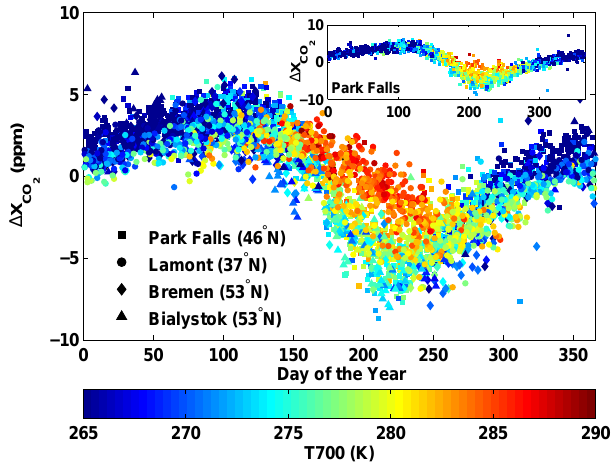
Fig. 6. Detrended X CO seasonal cycles measured at the four TC- 2 CON stations. The colors are the free-troposphere temperatures (at 700hPa, denoted T700). The color bar is scaled to emphasize the spring and summer months. The summertime 1 X CO is lowest 2 when the T700 values are coolest, and highest when the T700 val- ues are warmest. The inset is Park Falls data alone, illustrating the increase in synoptic-scale “noise" in the